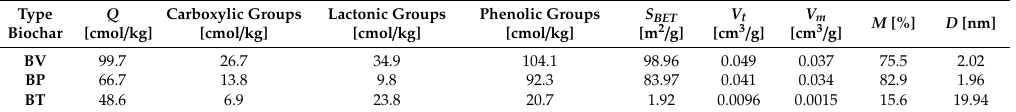
Table 1. Characteristics of biochars obtained from di ff erent biomasses ( Q : variable surface charge, S BET : specific surface area, V t : total pore volume, V m : micropore volume, M : micropore contribution, D : average pore